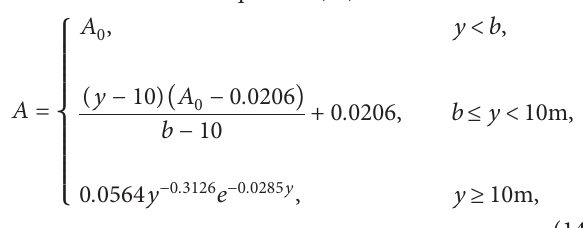
Figure 8: Correlation between peak ground acceleration and train speed.